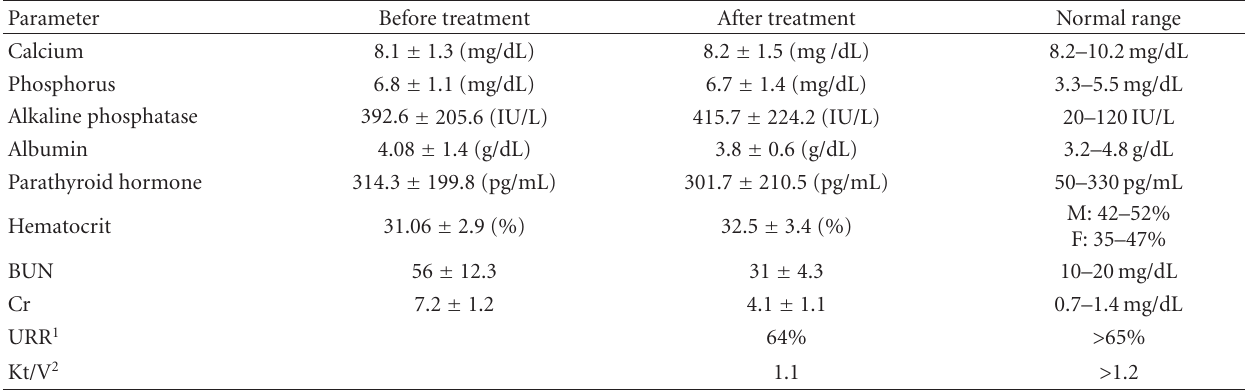
Table 2: The mean ± SD of laboratory tests before and after treatment with sertraline.